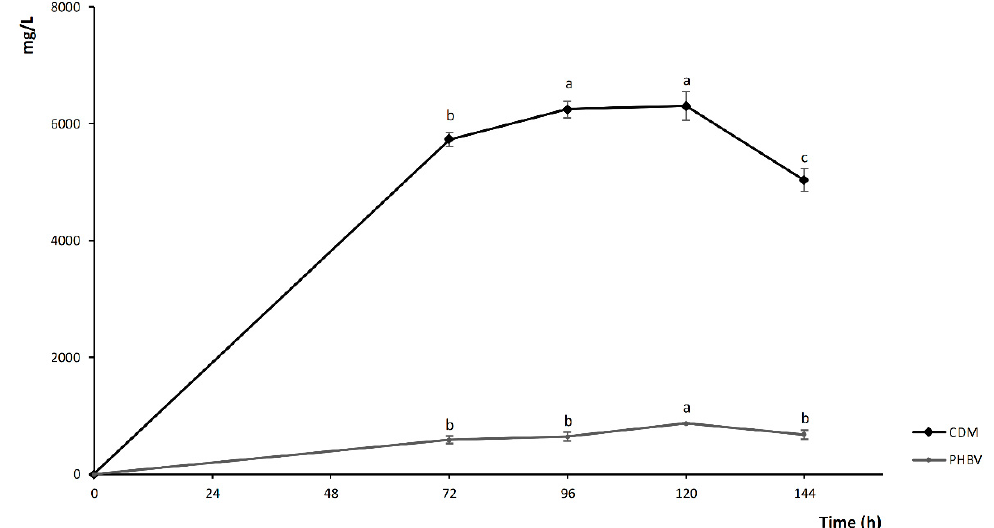
Figure 3. Haloferax mediterranei Cell Dry Mass (CDM) and PHBV production in R-NF supplemented with 1% ( v / v ) SL-6 and 10% ( w / v ) NaCl. Inoculum was made with 20% v / v active culture of Hfx. mediterranei DSM1411 grown (24 h at 37 °C) in HM372. Fermentation was carried out at 37 °C for 144 h. Error bars represent the standard deviation of three replicates. a–c Values in the same data series, with different superscript letters, differ significantly ( p < 0.05).